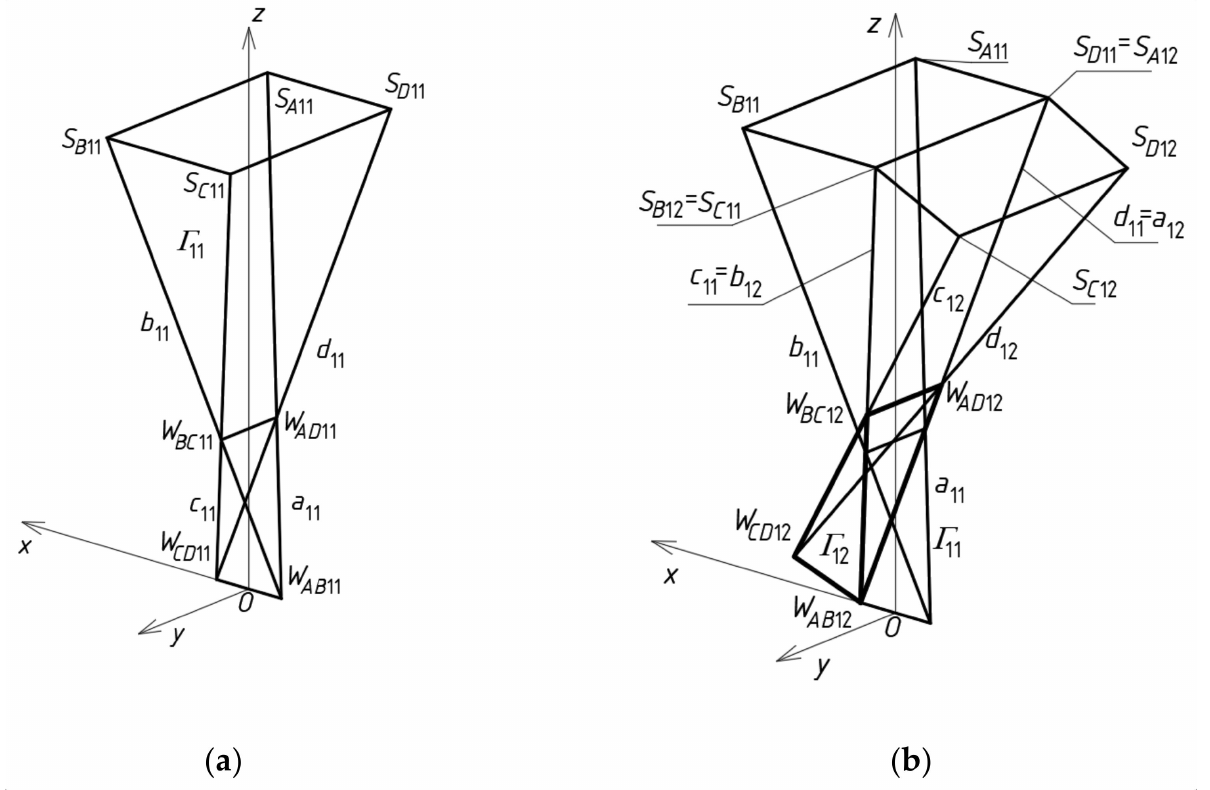
Figure 12. Tetrads of the ω r ‘s points belonging to: ( a ) Γ 11 ; ( b ) Γ 12